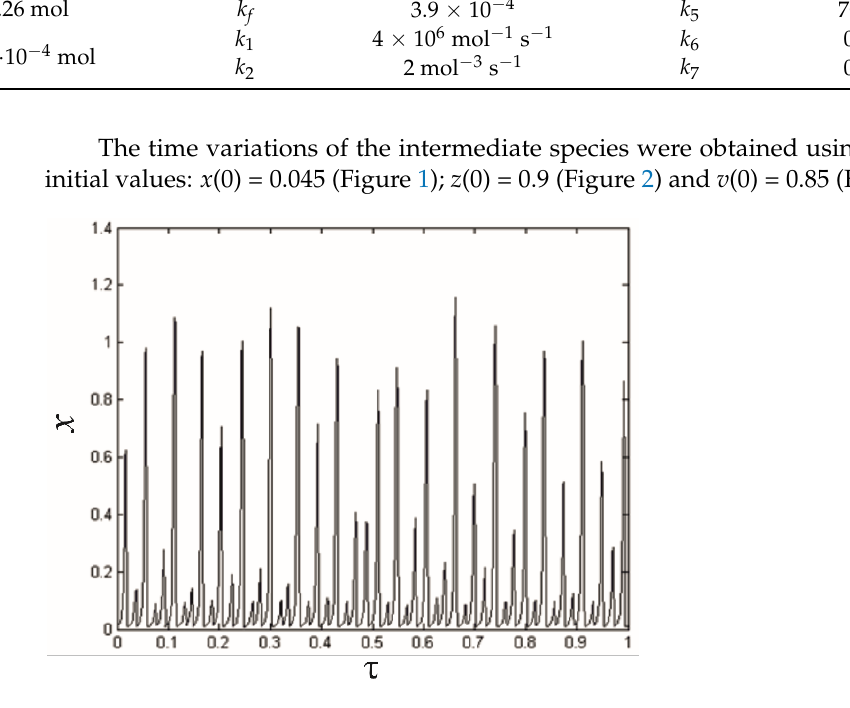
Figure 1. The evolution of the x ( τ ) concentration at low flux (α = 6000/9; β = 8/23; A = 0.1 mol; C = 8.33 × 10 −4 mol; M = 0.25 mol; H = 0.26 mol and k f = 3.9 × 10 −4 ) and initial values: x (0) = 0.045, z (0) = 0.9 and v (0) = 0.85.